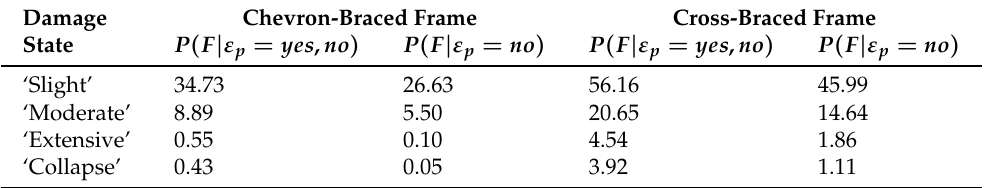
Figure 12. Seismic risk for the two frames under different performance thresholds, where for ( a ) the failure definition also includes the failure due to low-cycle fatigue, and for ( b ) the failure definition does not include the failure due to low-cycle fatigue. Table 1. Failure probability of braced frames corresponding to different damage states (in